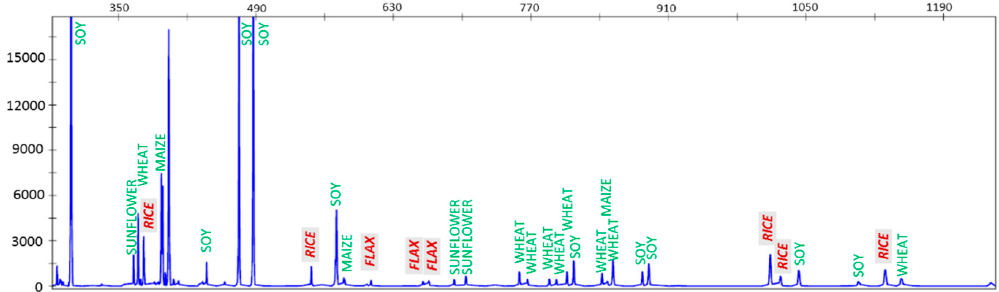
Figure 2. Feed sample analysis. The capillary electrophoresis (CE)-TBP profile gained from one cattle feed sample. The peak size (base pairs) is reported on the x axis and the fluorescence intensity (RFU, relative fluorescence unit) on the y axis. Green labels indicate specific peaks generated by DNA amplification of declared ingredients (sunflower, wheat, maize and soy), red labels indicate amplicons originated from detected undeclared species (flax and rice in gray boxes).